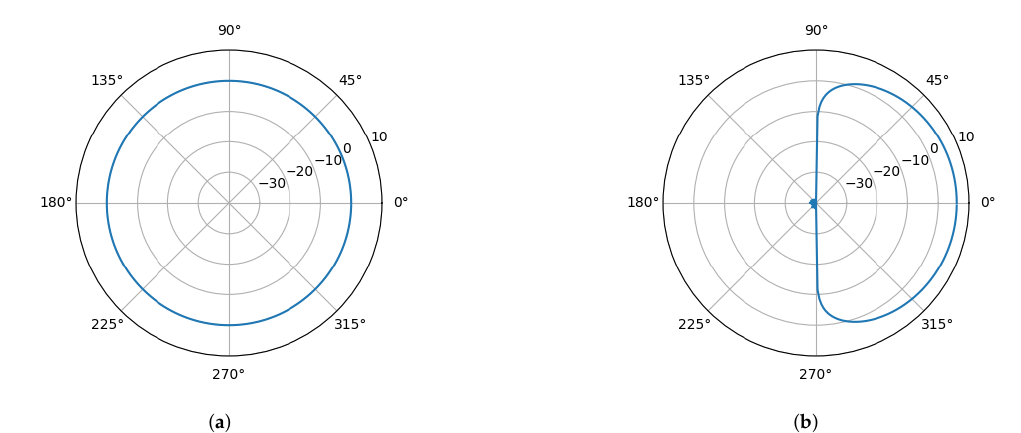
Figure 3. Elevation plane gain patterns (dBi) of the considered isotropic element and patch element. ( a ) Isotropic antenna; ( b ) Patch antenna.